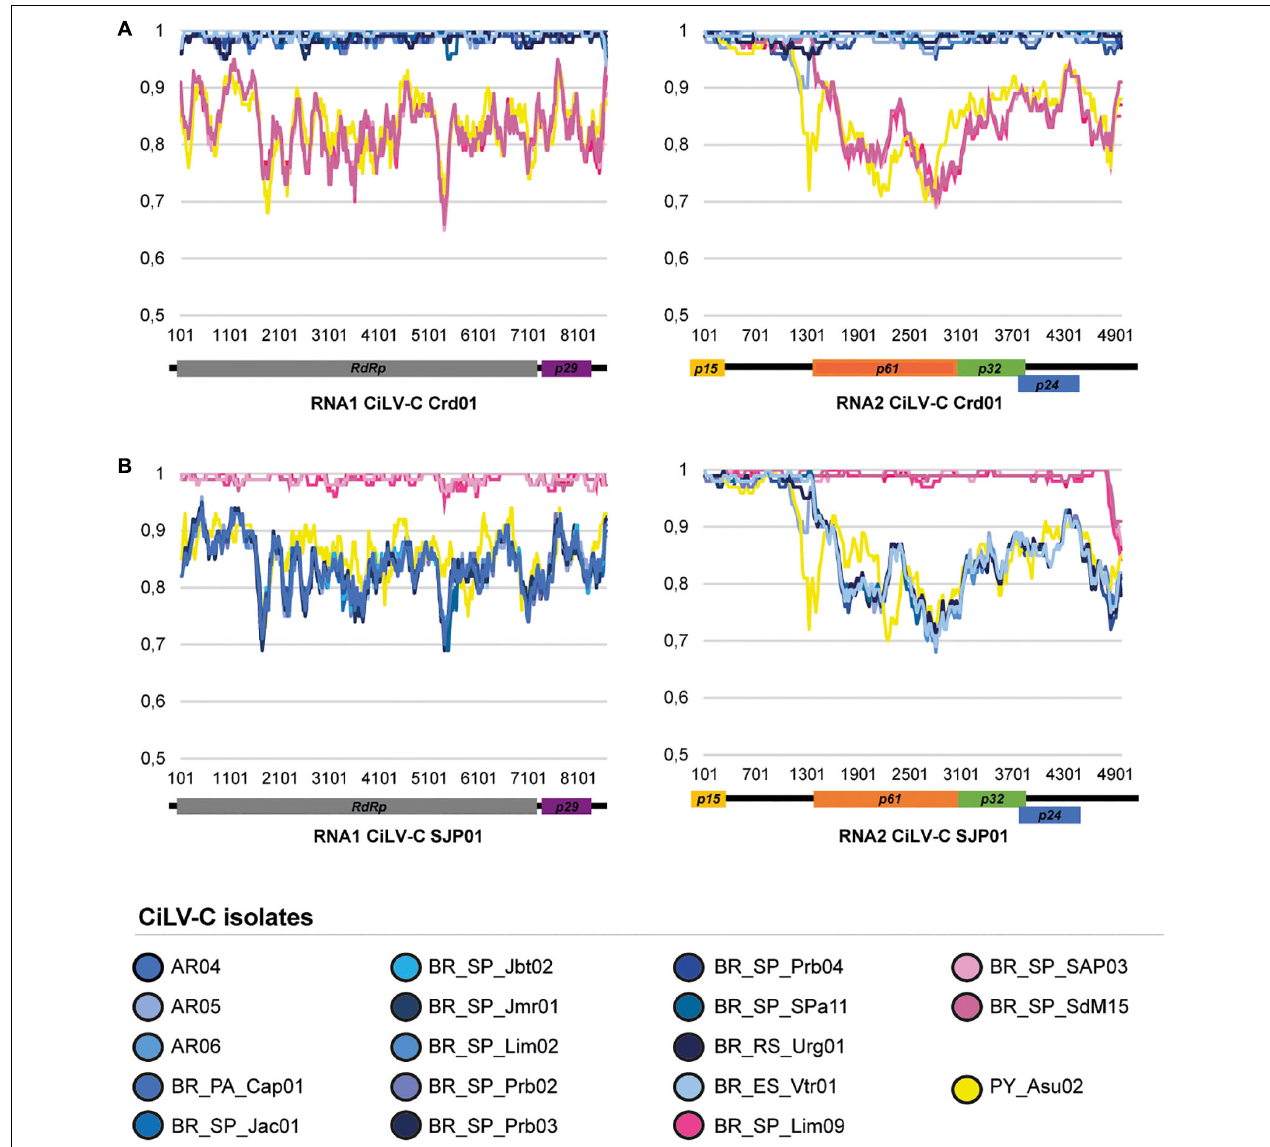
FIGURE 2 | Similarity plots of the nucleotide sequences of the RNA1 and RNA2 of the CiLV-C isolates. The full-length genome sequences of the 18 studied CiLV-C isolates were compared to those of the type-member viruses of the clades CRD (A) and SJP (B) . Curves depict the comparison between the analyzed and a reference genome. Each plotted point is the percent identity (vertical axis) within a sliding window 200 bp wide centered on the position plotted, with a step size between points of 20 bp. The horizontal axis indicates the nucleotide positions across the RNA1 and RNA2 molecules of the reference genomes. The horizontal bars above the curves are a cartoon of the ORFs of the CiLV-C genome. Plots were generated using SimPlot (Lole et al.,